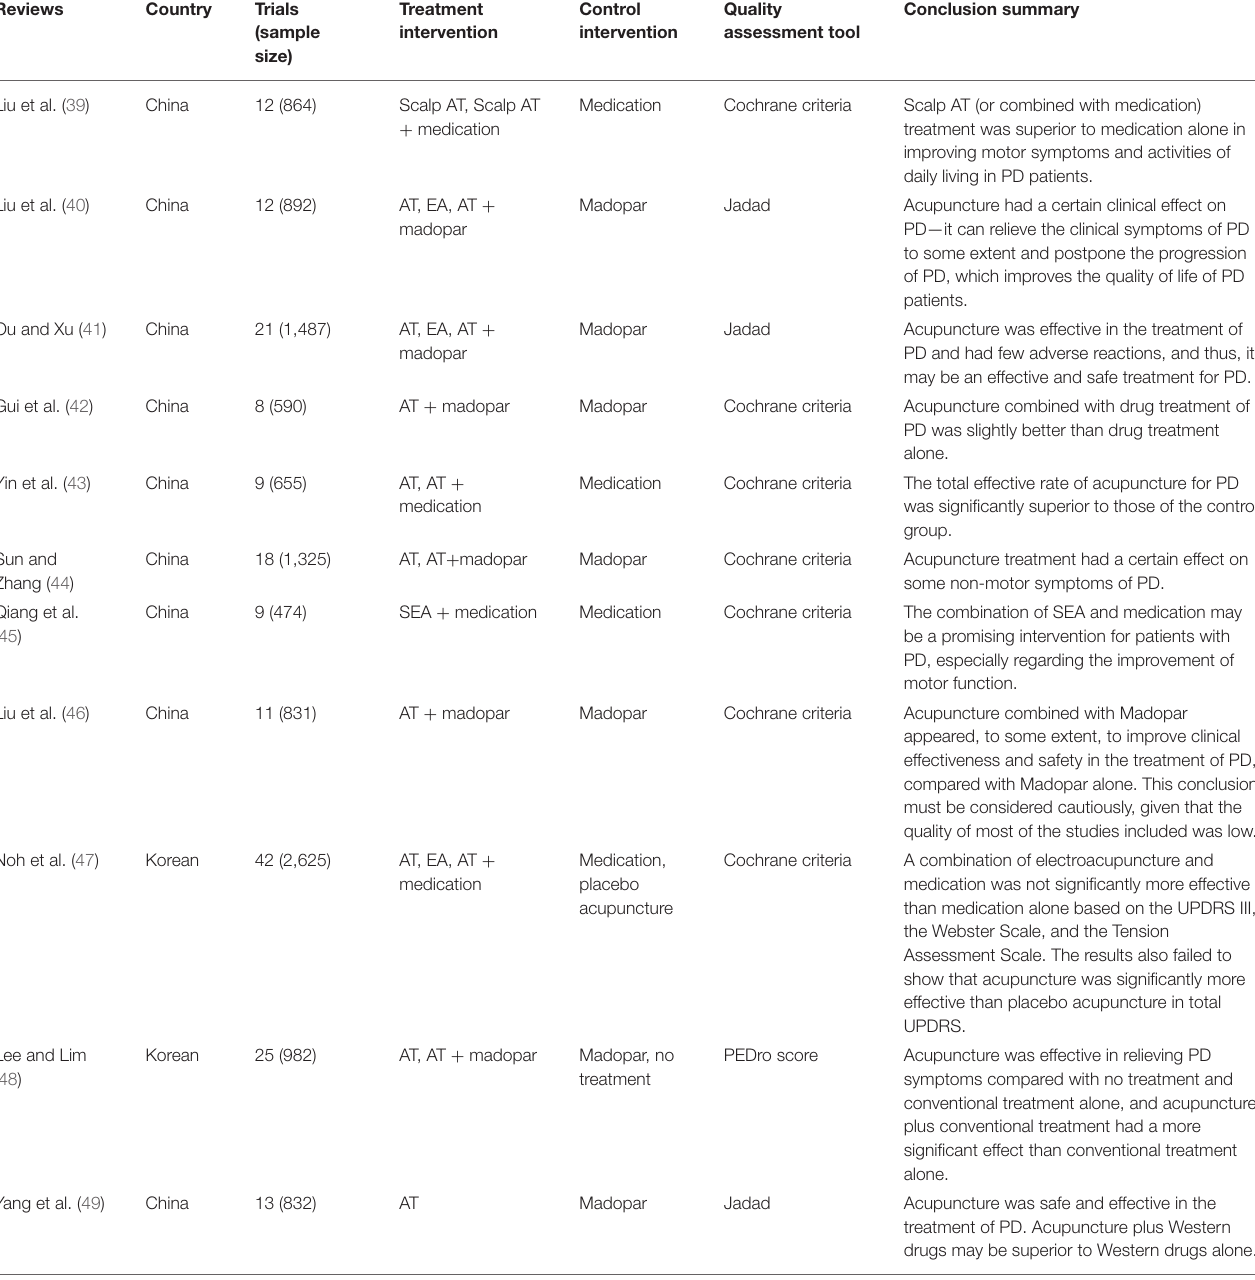
TABLE 2 | Characteristics of the included